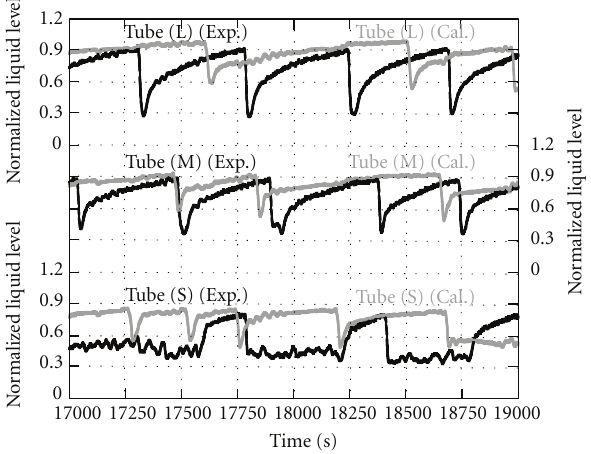
Figure 15: LSTF and RELAP5 results for collapsed liquid levels in upflow side of SG U-tubes in loop with PZR during large-amplitude level oscillation